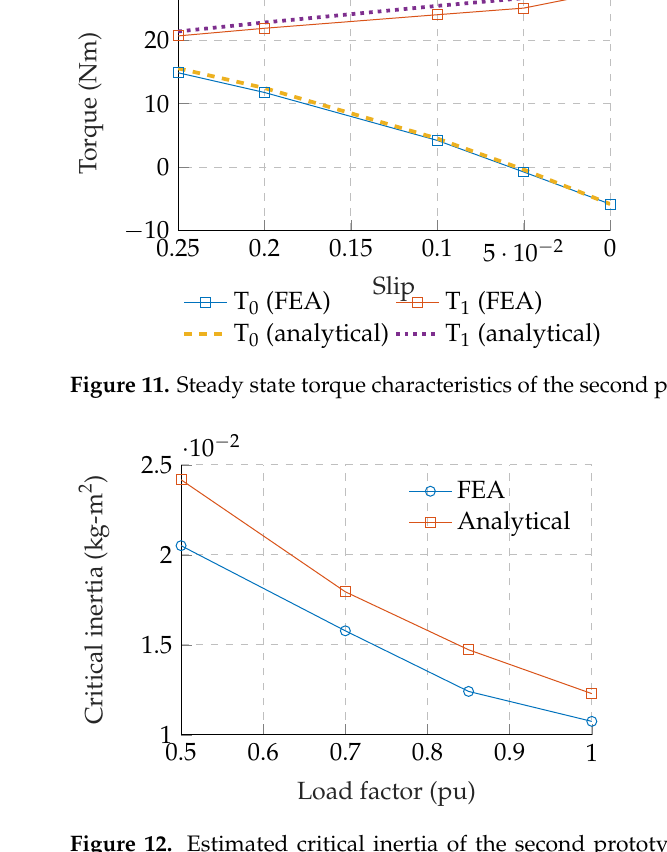
Figure 12. Estimated critical inertia of the second prototype for load torque quadratic with ro- tor